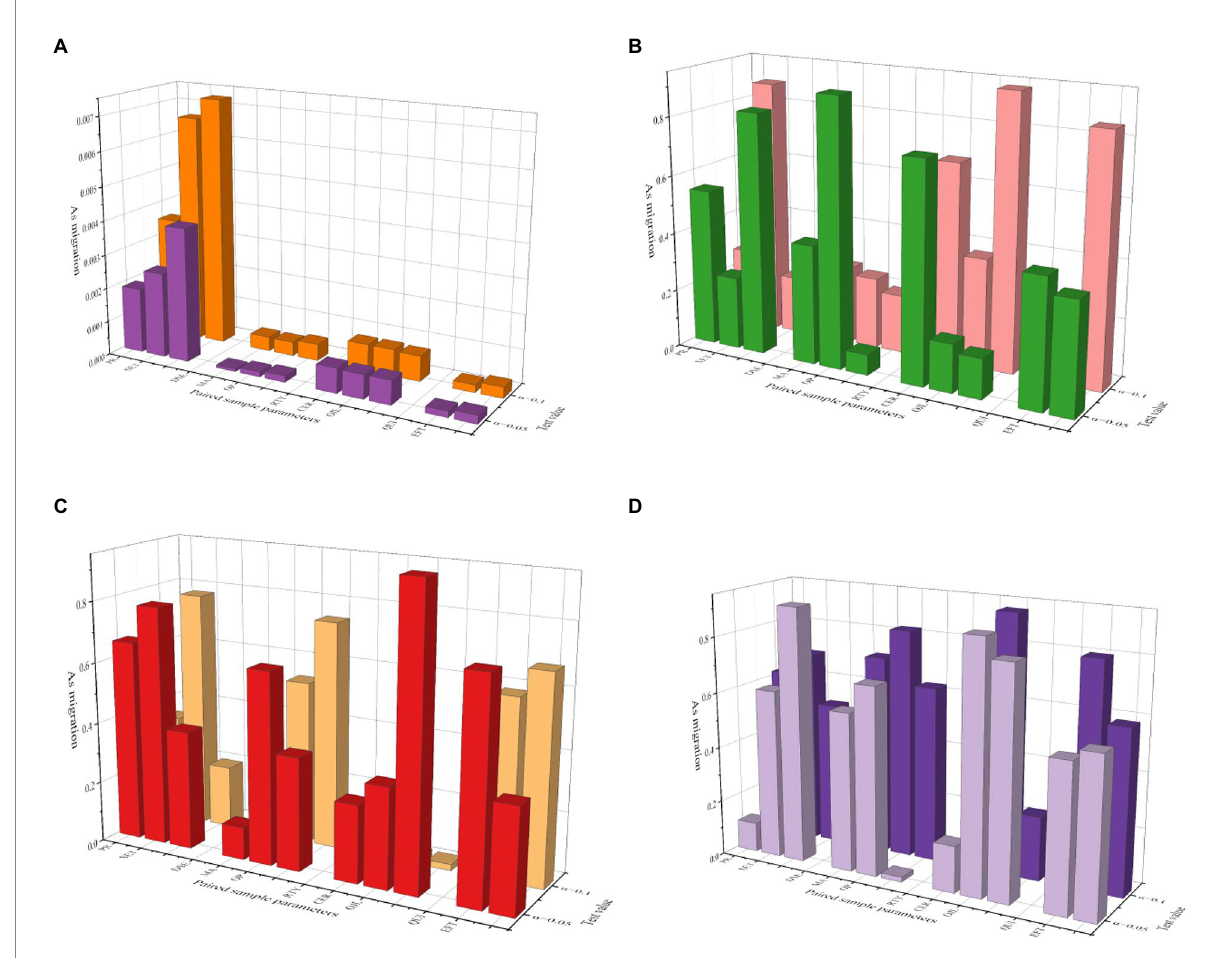
FIGURE 3 Trend of AS transfer